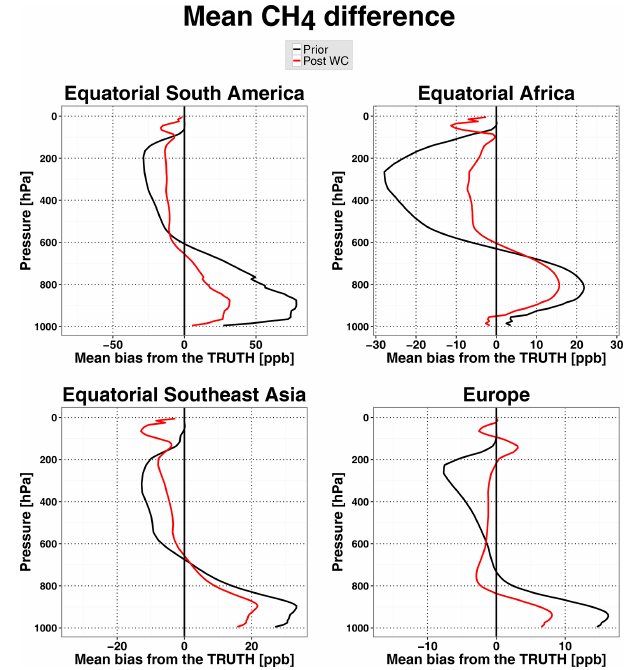
Figure 2. Mean vertical profiles of the CH 4 differences in March 2010 in the OSSE with biased convection for the four regions de- picted in Fig. 1. The differences are between (black lines) the a pri- ori and the true CH 4 state and between (red lines) the WC optimized state and the true CH 4